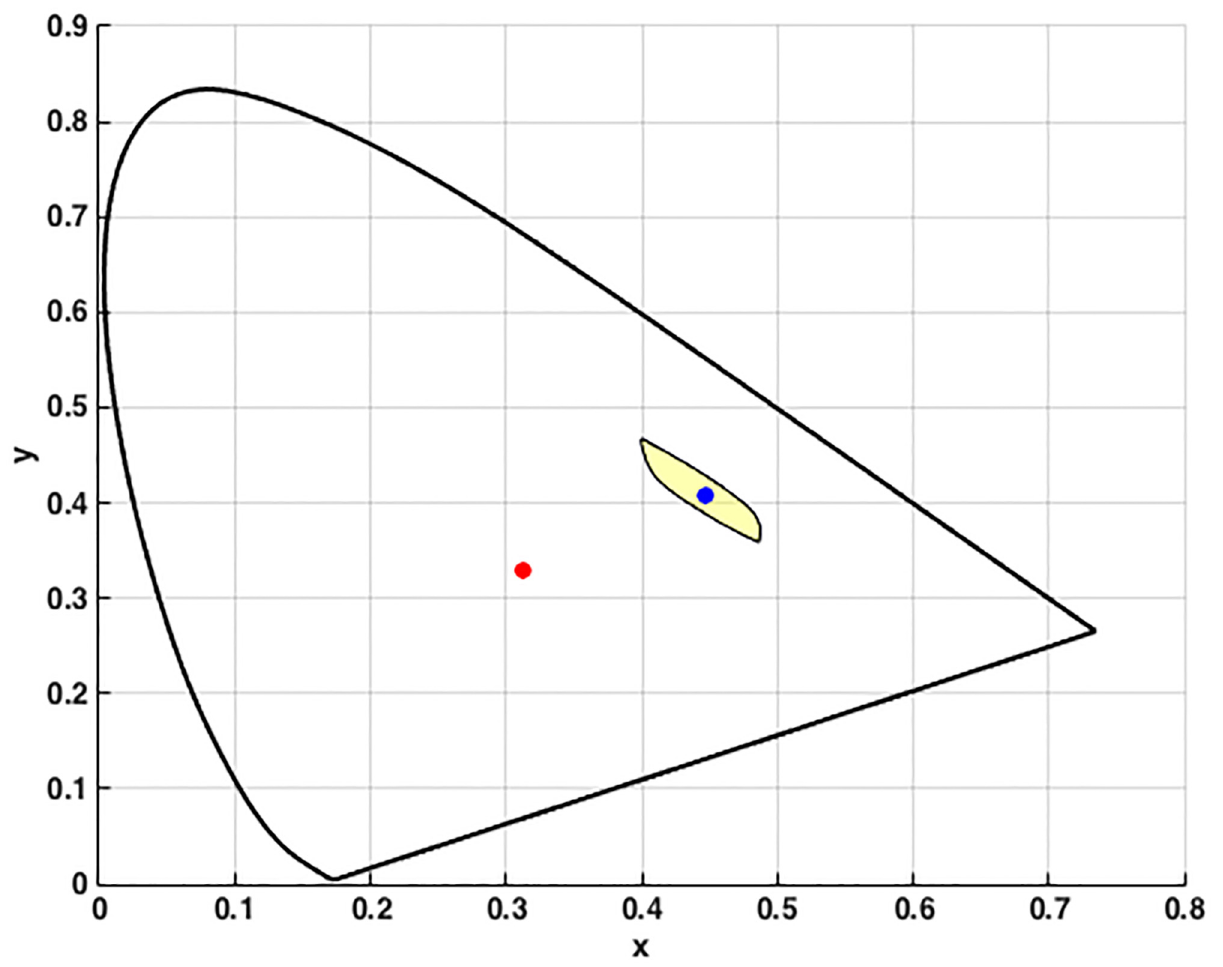
Fig 3. Chromaticity mismatch area (yellow area) for the flat grey reflectance when CIE illuminant D65 is replaced by CIE illuminant A plotted in the CIE 1931 xy-chromaticity diagram. The red dot indicates the chromaticity of the flat grey under CIE D65 and the blue dot the corresponding chromaticity under CIE A lying inside the metamer mismatch